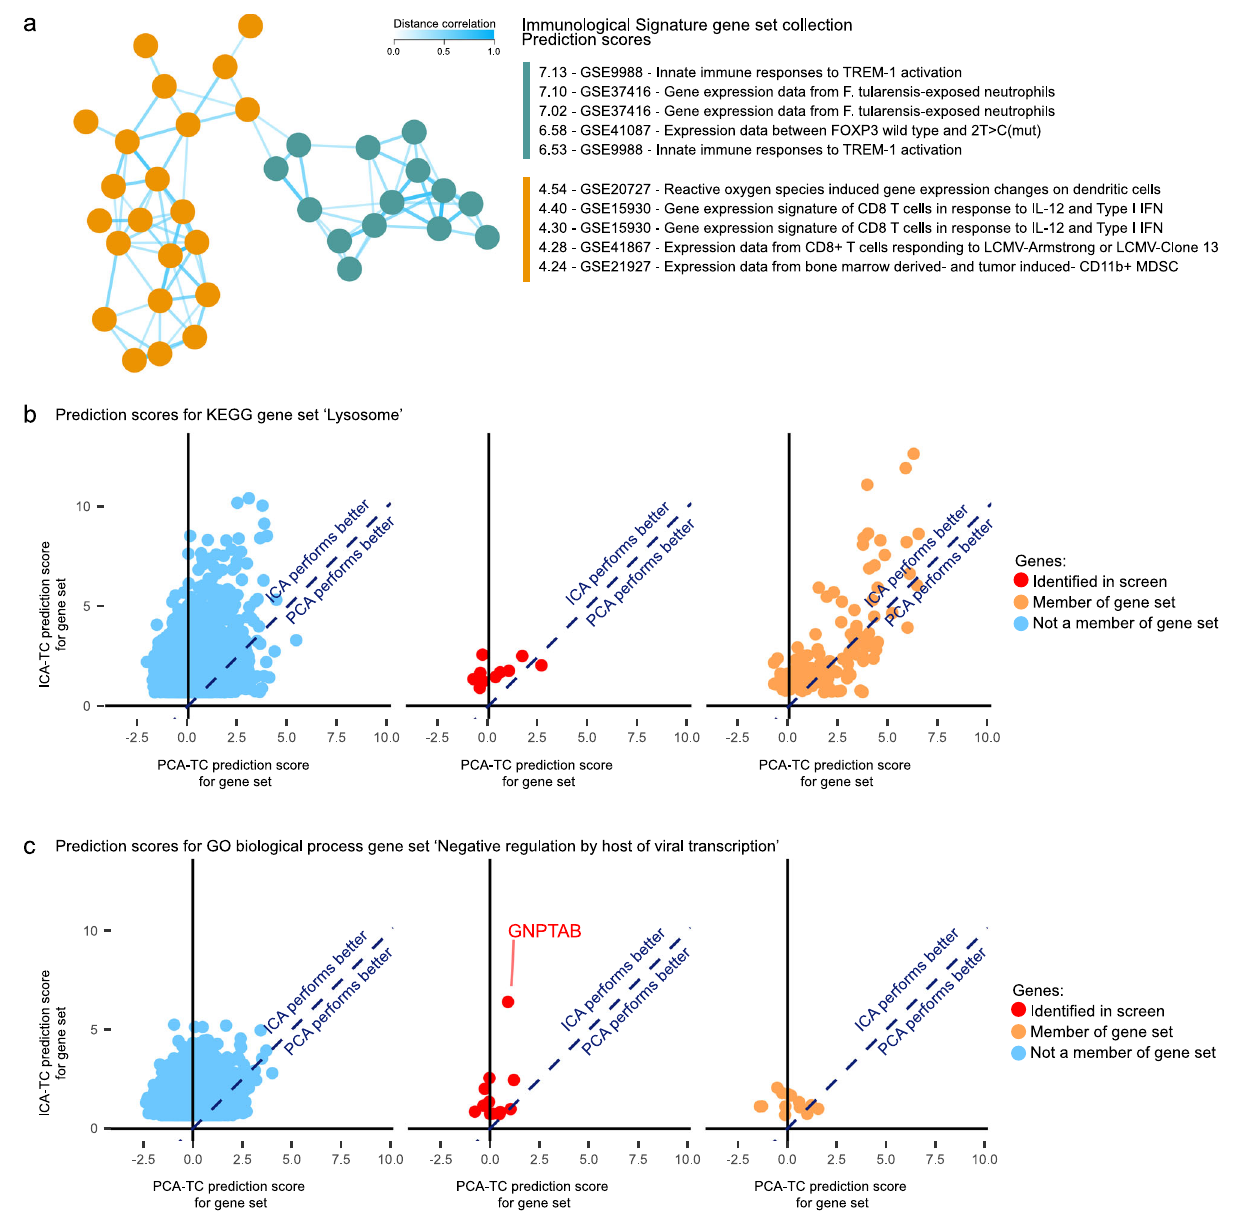
Fig. 8 GENETICA predictions for other CRISPR-based screens. a Co-functionality network generated with 111 genes prioritized in a CRISPR screen investigating the in fl ammatory response to bacterial lipopolysaccharide. Two clusters were formed that showed enrichment for predicted involvement in an in fl ammatory response (right cluster) and oxidative stress response in dendritic cells (left cluster). Predictions in this co-functionality network were based on the Immunological Signatures gene set collection. Only genes with a co-functionality above a threshold of R > 0.5 are shown in the network. b Scatterplots of ICA-TC-based ( y -axis) and PCA-TC-based ( x -axis) prediction scores of all genes for the KEGG lysosome gene set. The orange- and blue- colored dots designate the membership of genes to the respective KEGG lysosome gene set, and red dots designate genes identi fi ed in the CRISPR screen mentioned in the text. c Scatterplots of ICA-TC-based ( y -axis) and PCA-TC-based ( x -axis) prediction scores of all genes for the GO Biological Process gene set Negative regulation of viral transcription by the host. The orange and blue color dots designate the membership of genes to the respective GO Biological Process gene set, and red dots designate genes identi fi ed in the CRISPR screen mentioned in the text; the dot corresponding to the GNPTAB gene is